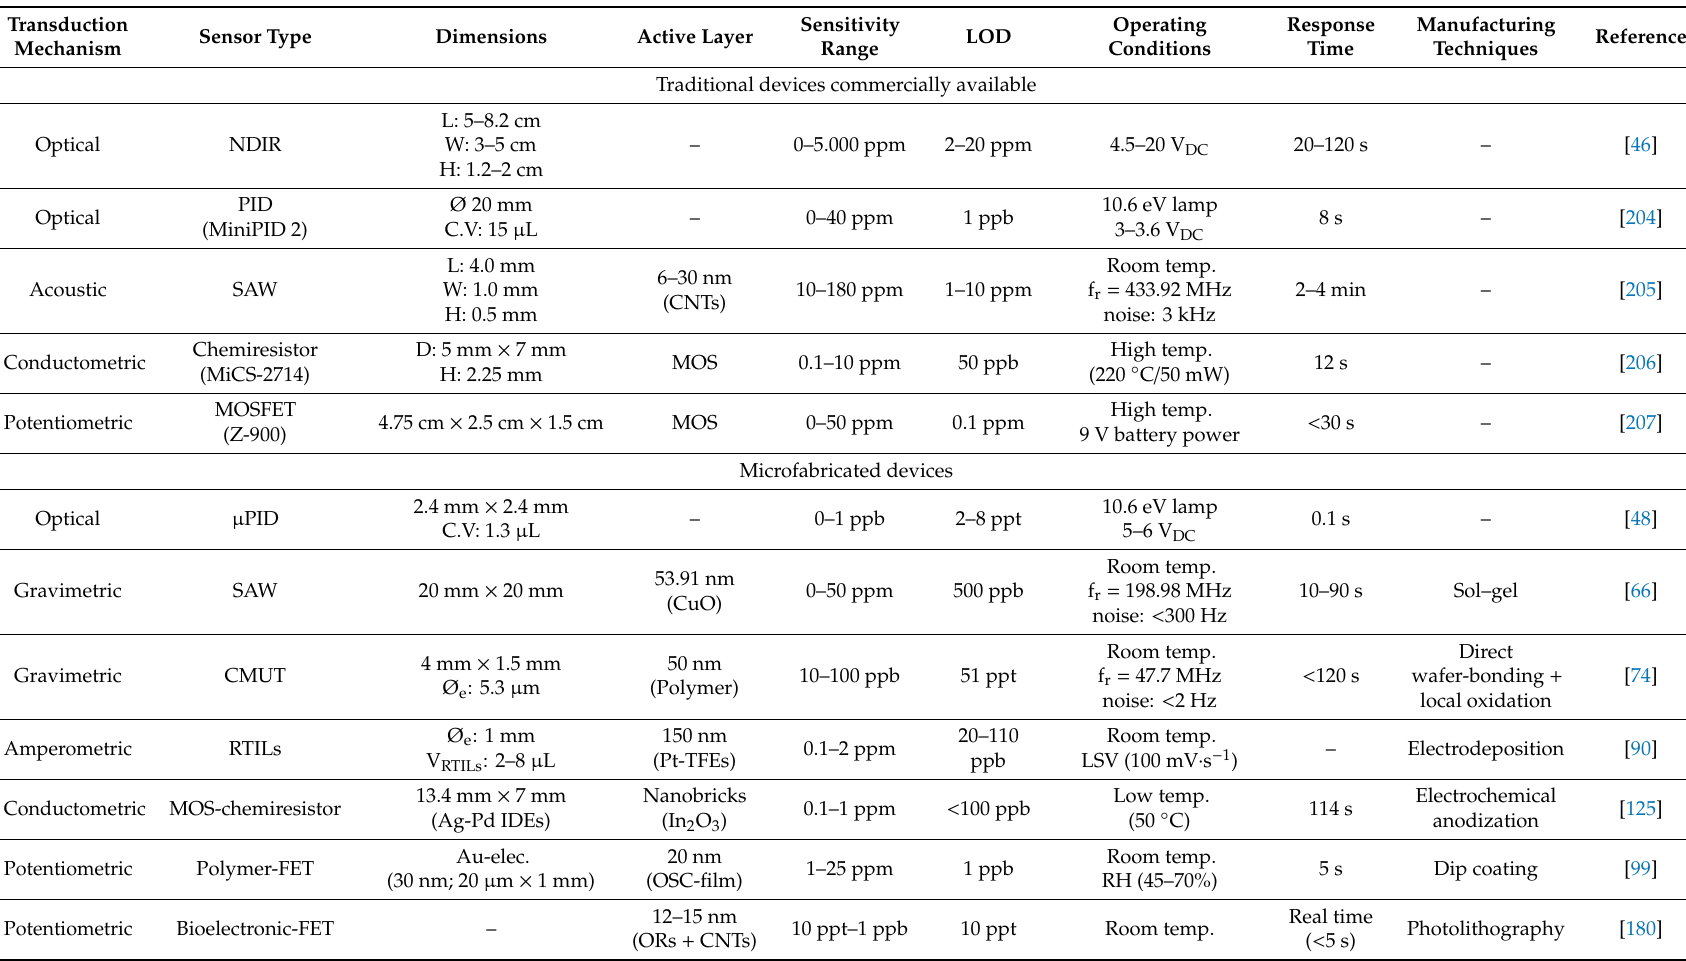
Table 1. Characteristics and operating principles of common sensors for volatile organic compounds (VOCs) detection. Microfabricated devices are compared to commercial units already in the